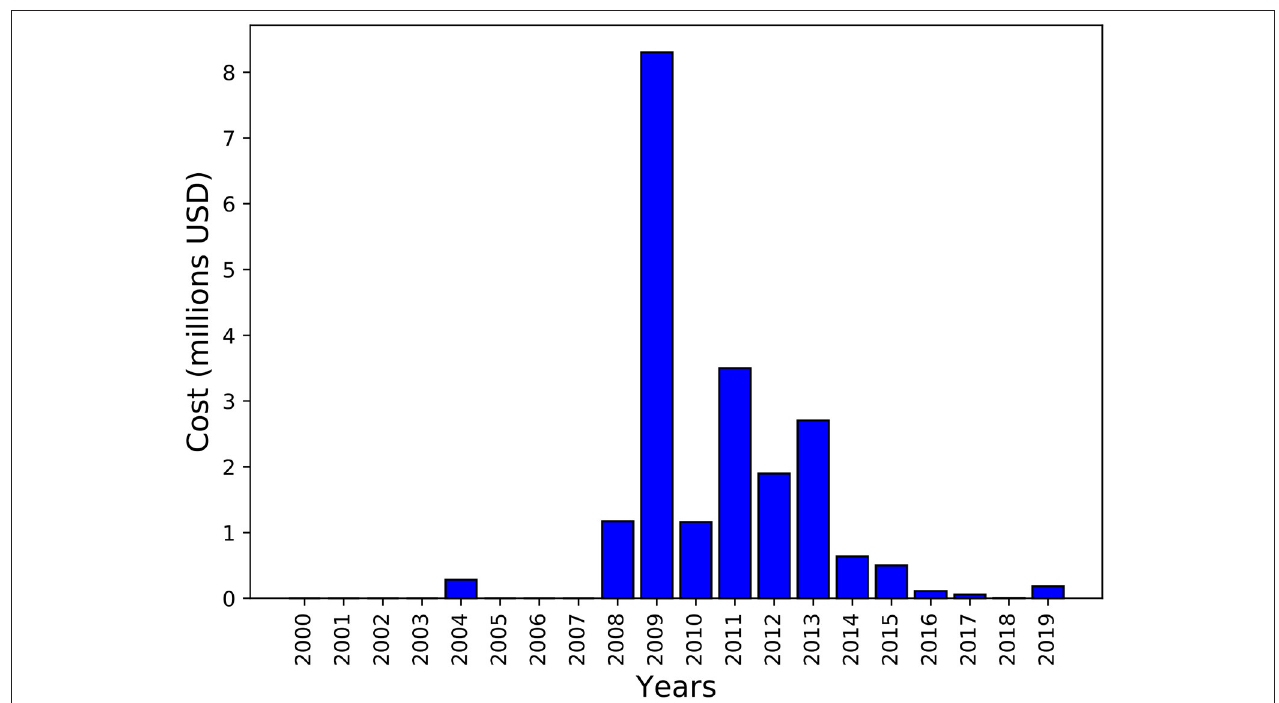
FIGURE 5 | The recorded annual amount of money spent in response to weather-related